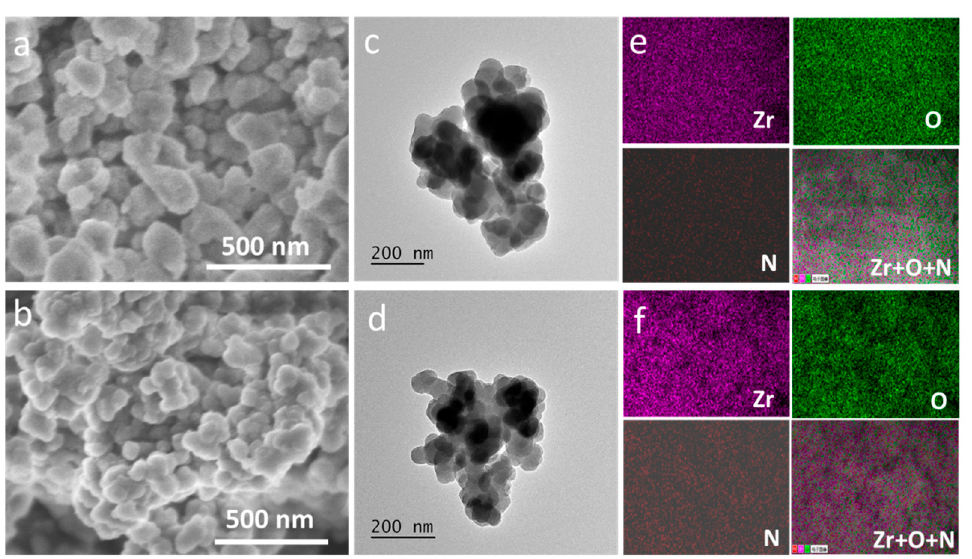
Figure 1. The SEM ( a ), TEM ( c ) and EDS ( e ) mapping images of UiO-66; the SEM ( b ), TEM ( d ) and EDS ( f ) mapping images of UiO-66-NH 2 .